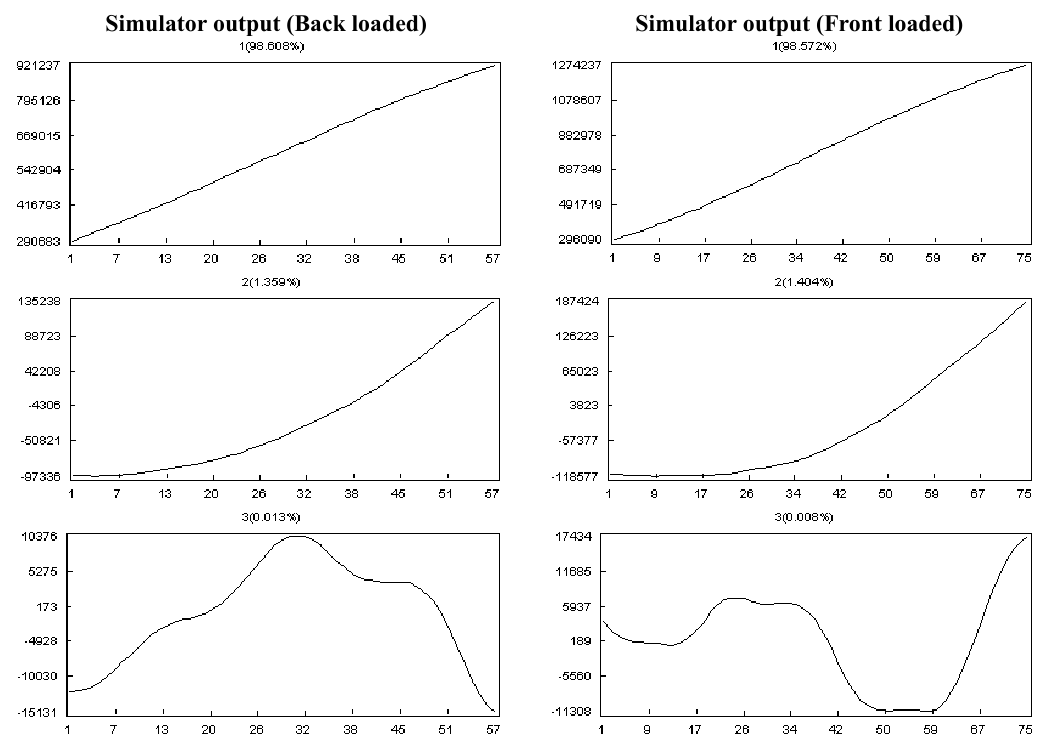
Figure 18. Principal components related to the first three eigentriples of the time series in two different settings: front-loaded and back-loaded work contour. settings: front-loaded and back-loaded work